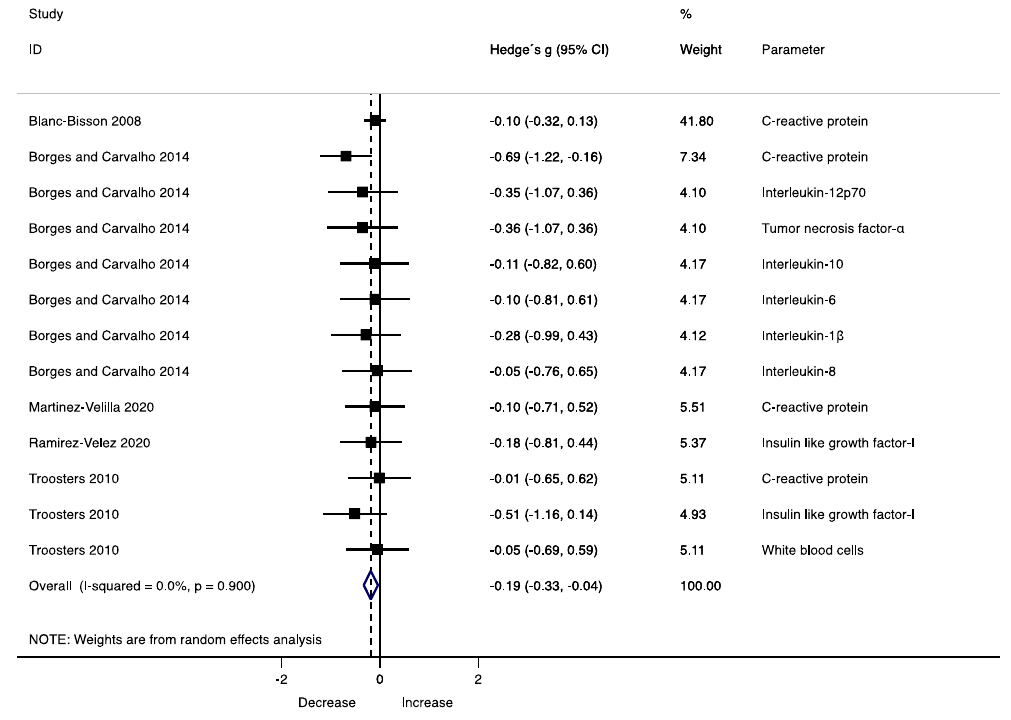
Figure 2. Forest plot showing the effect size (Hedges’ g) of physical exercise programs on overall inflammatory profile.